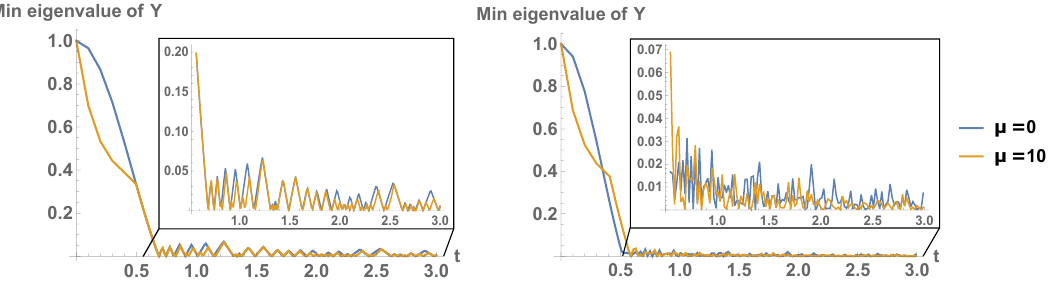
Figure 9 . The smallest eigenvalue of the super-operator Y µ for the SYK model with the chaotic 3-body deformation δH 3 , with N = 6 (left) and N = 8 (right) for µ = 0 (blue) and µ = 10 (gold). The values for t & 0 . 5 are displayed inset for visual